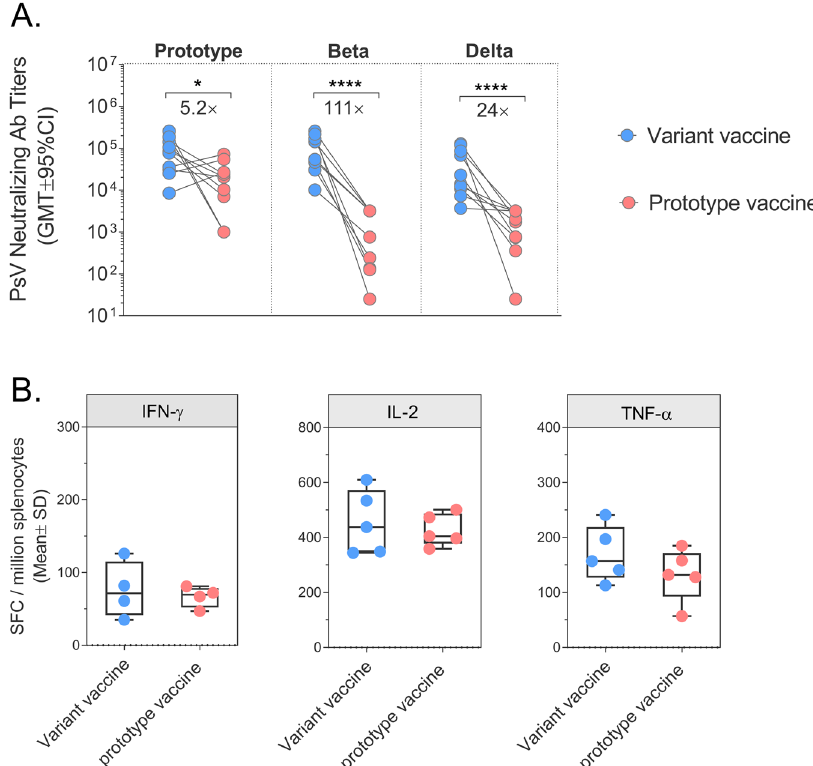
Fig. 4 Comparison of immune responses between variant vaccine and prorotype vaccine in BALB/c mice. A Pseudovirus neutralizing antibody titers (GMT ± 95%CI) against prototype SARS-CoV-2, Beta strain, and Delta strain at day 35. B Results (mean ± SD) of S-speci fi c ELISPOT at day 35. Note: * p < 0.05; **** p <